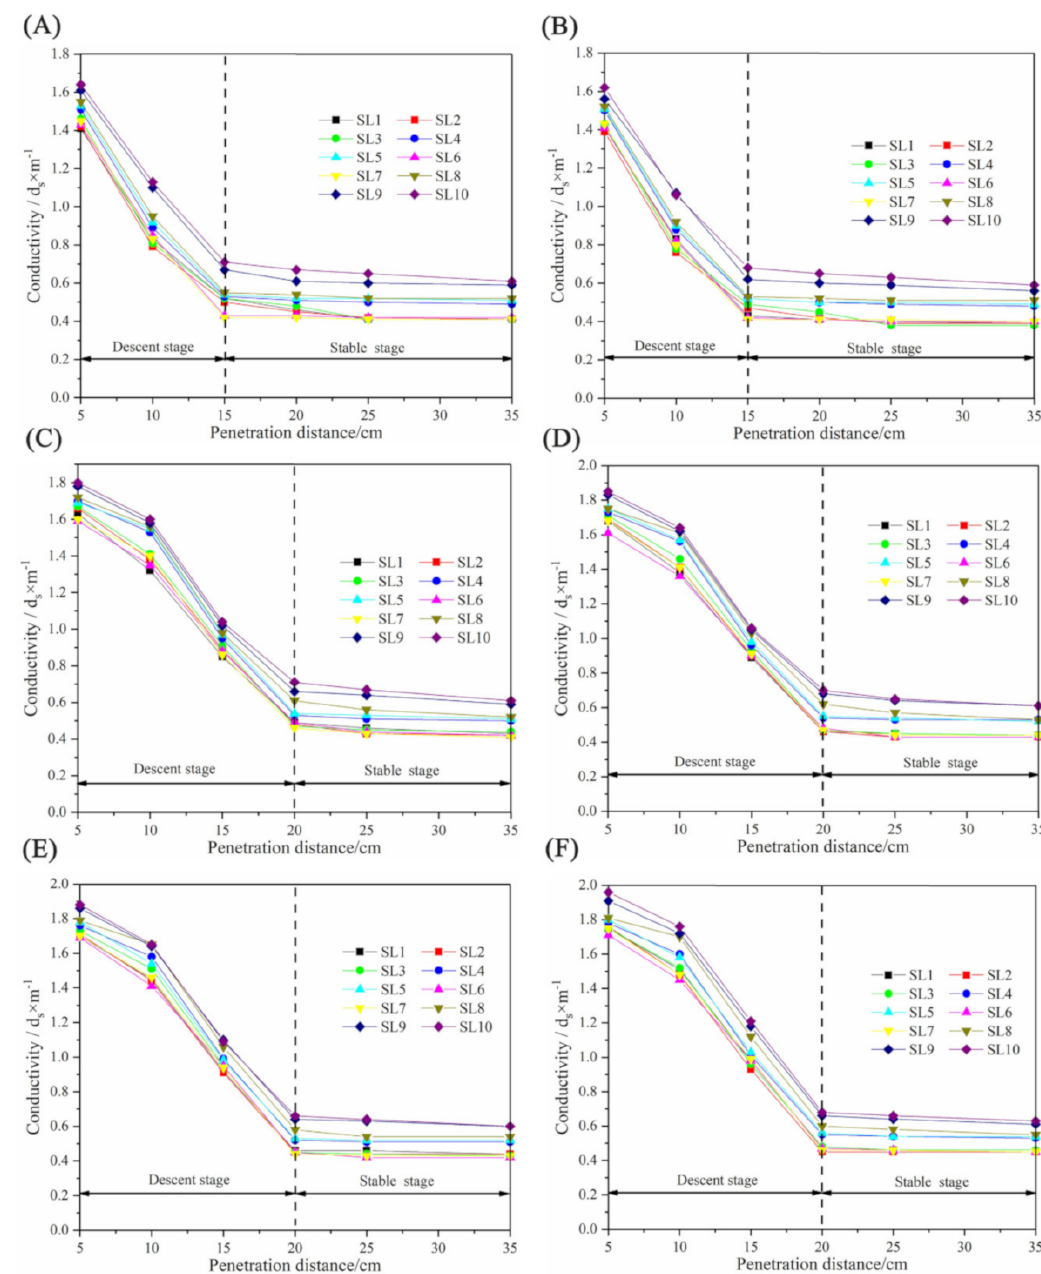
Figure 12. Variation curves of electric conductivity: ( A ) cutter head CH1, rotation speed of cutter head = 0 rpm, ( B ) cutter head CH2, rotation speed of cutter head = 0 rpm, ( C ) cutter head CH1, rotation speed of cutter head = 0.5 rpm, ( D ) cutter head CH2, rotation speed of cutter head = 0.5 rpm, ( E ) cutter head CH1, rotation speed of cutter head = 1.0 rpm, ( F ) cutter head CH2, rotation speed of cutter head = 1.0